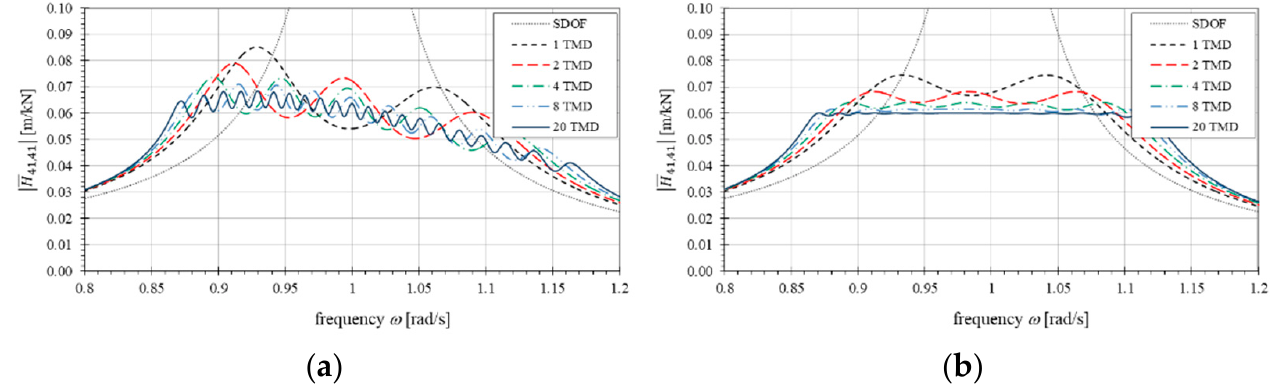
(cid:12) (cid:12) Figure 6. Module graph of a FRF (cid:12) H 41,41 (cid:12) for optimal parameters and a different number of TMDs: ( a ) for the J 1 objective H for optimal parameters and a different number of Figure 6. Module graph of a FRF 41,41 function; ( b ) for the J 2 objective function. TMDs: ( a ) for the J 1 objective function; ( b ) for the J2 objective function. k ζ β values obtained for the J 1 objective function. Table 3. Optimal , , t t k k k